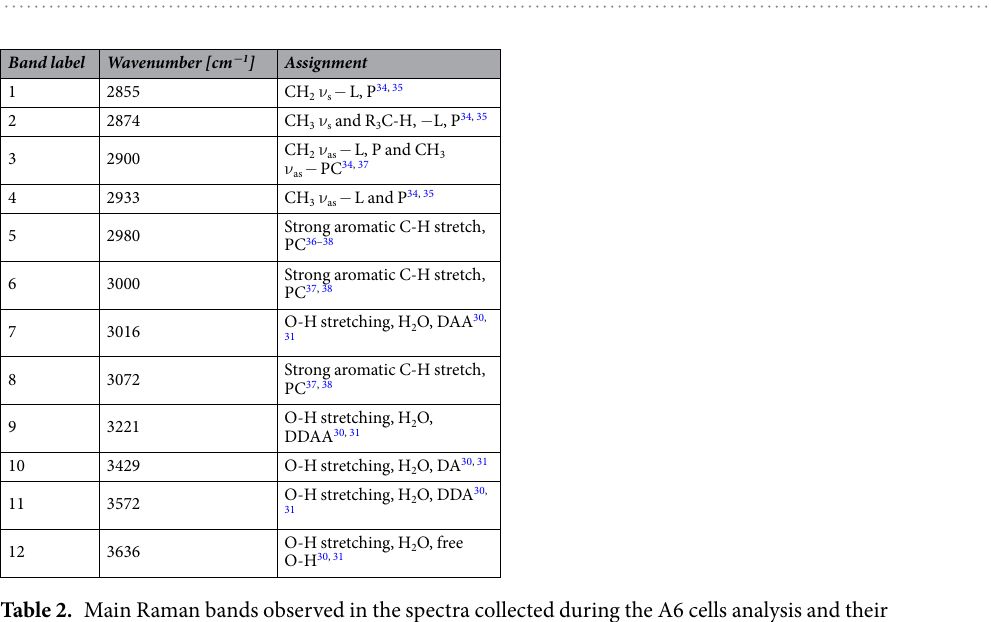
Figure 6. Profiles of the intensity ratio r , as retrieved from control ( a ) and aldosterone treated ( b ) A6 cells,